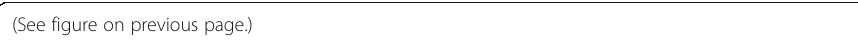
(See figure on previous page.) Fig. 4 Forest plot for neurobehavioural outcome (SMD) and 95% confidence intervals (CI) for select subgroups. Shaded area is the 95% CI of the global estimate. Percentage in parentheses is meta-analytic weight. “ Unknown ”